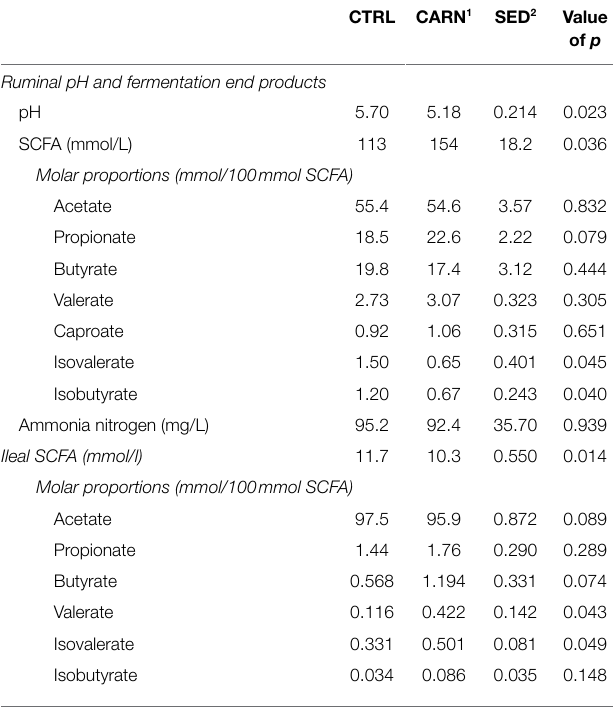
TABLE 5 | Ruminal pH and short-chain fatty acids (SCFA) profile at ruminal and ileal level of early feed restricted lambs being fed the control (CTRL) or the L-Carnitine diet (CARN) during the fattening